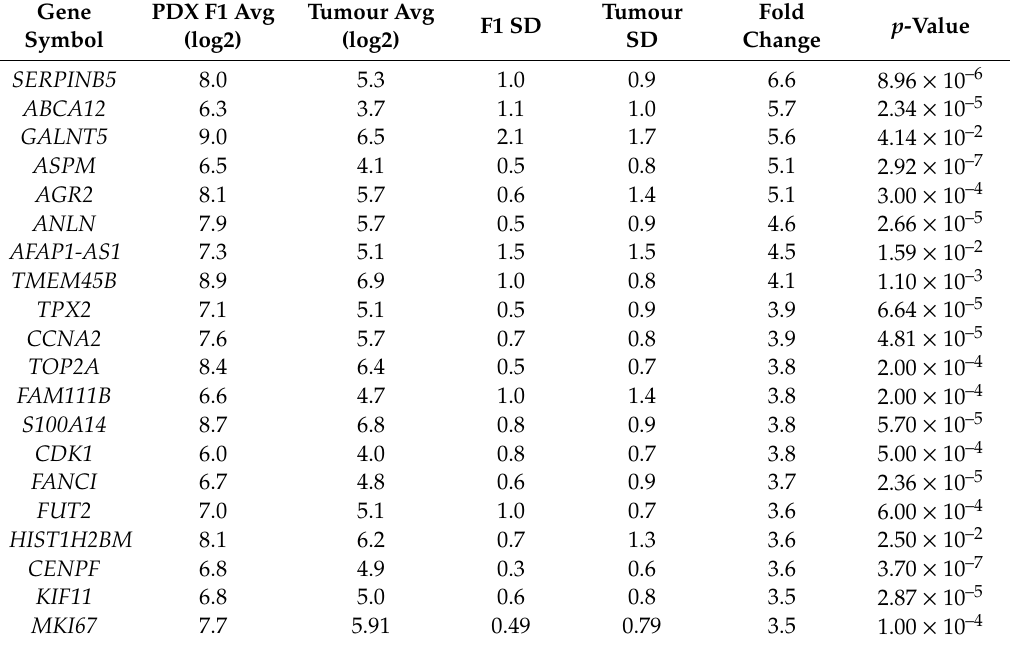
Table 7. Top 20 di ff erentially expressed genes upregulated in a comparison of tumour vs. F1 samples, ordered by fold change.